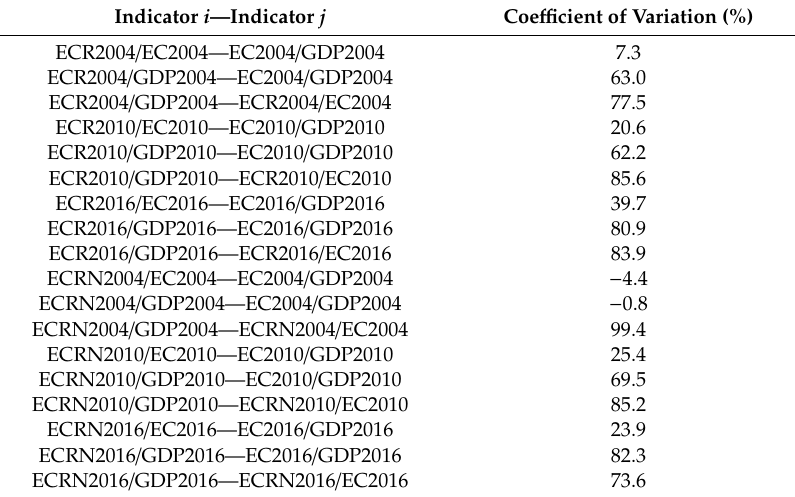
Table 4. Coe ffi cients of variation of indicators.